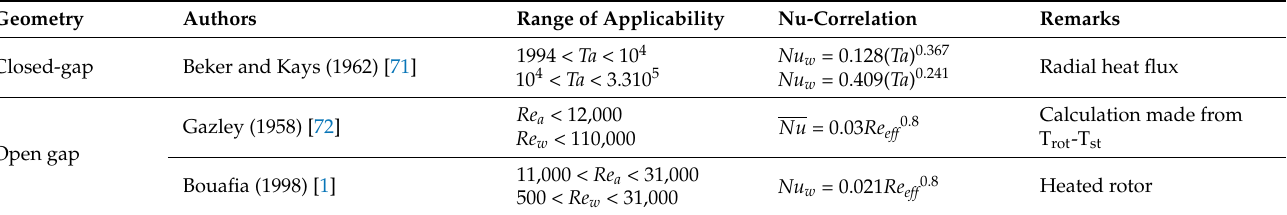
Table 4. Scaling relationships obtained in rotating annular ducts in forced regime of